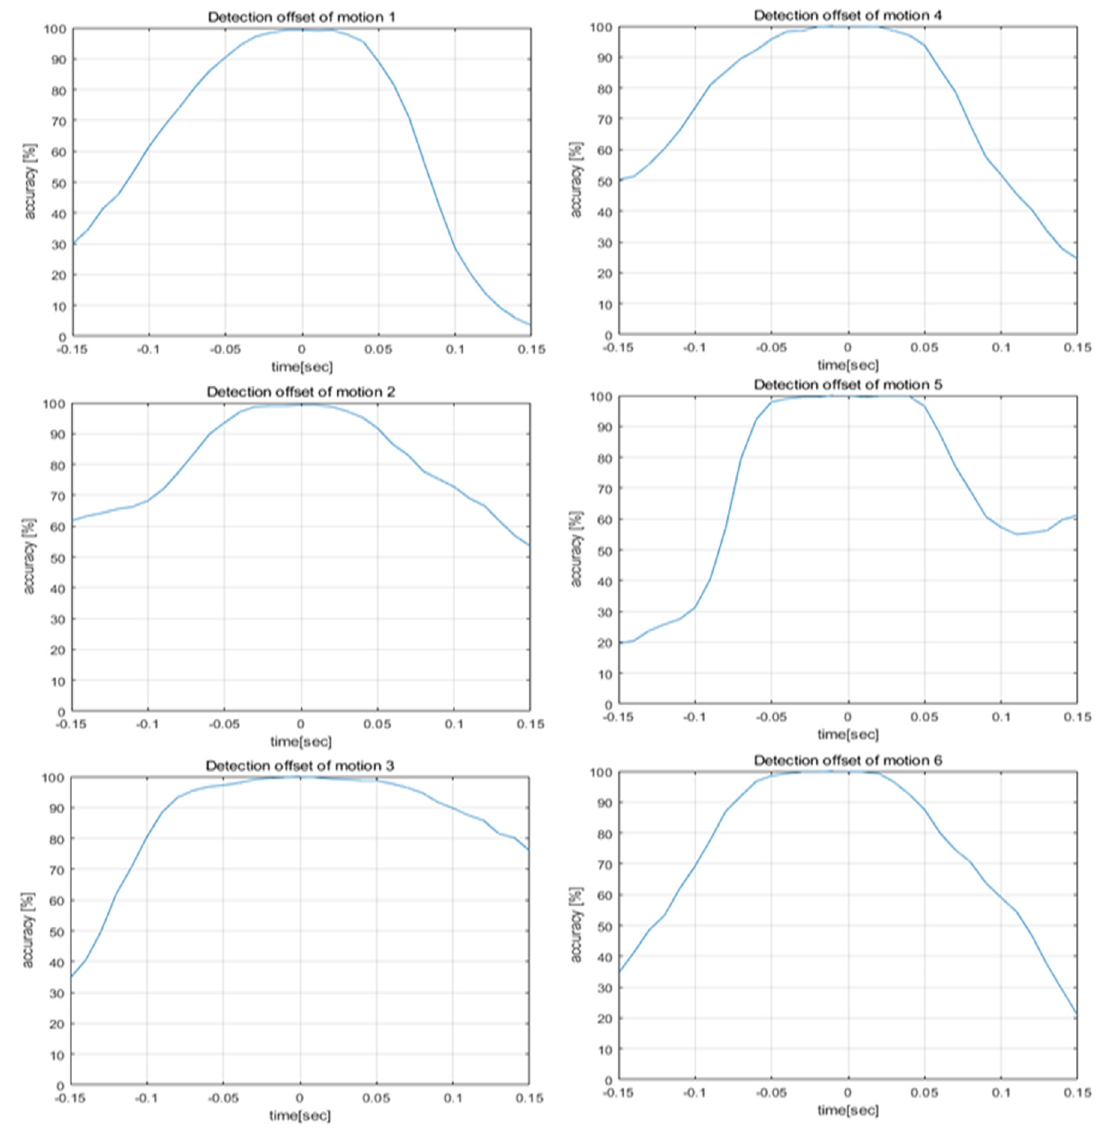
Figure 8. The performance drops caused by detection offset in motion 1 to 6.